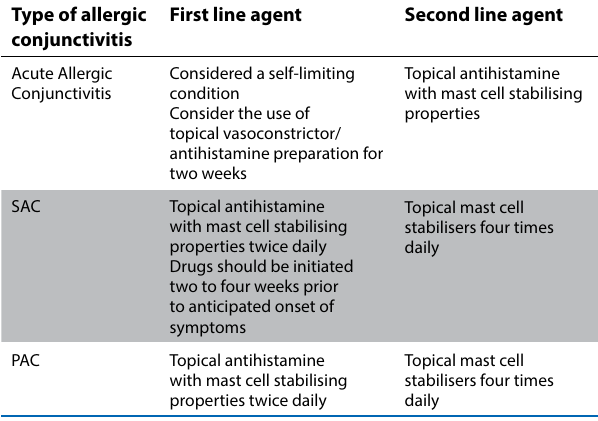
Table 4: Rational drugs use of the different therapeutic modalities for the different types of allergic rhinitis